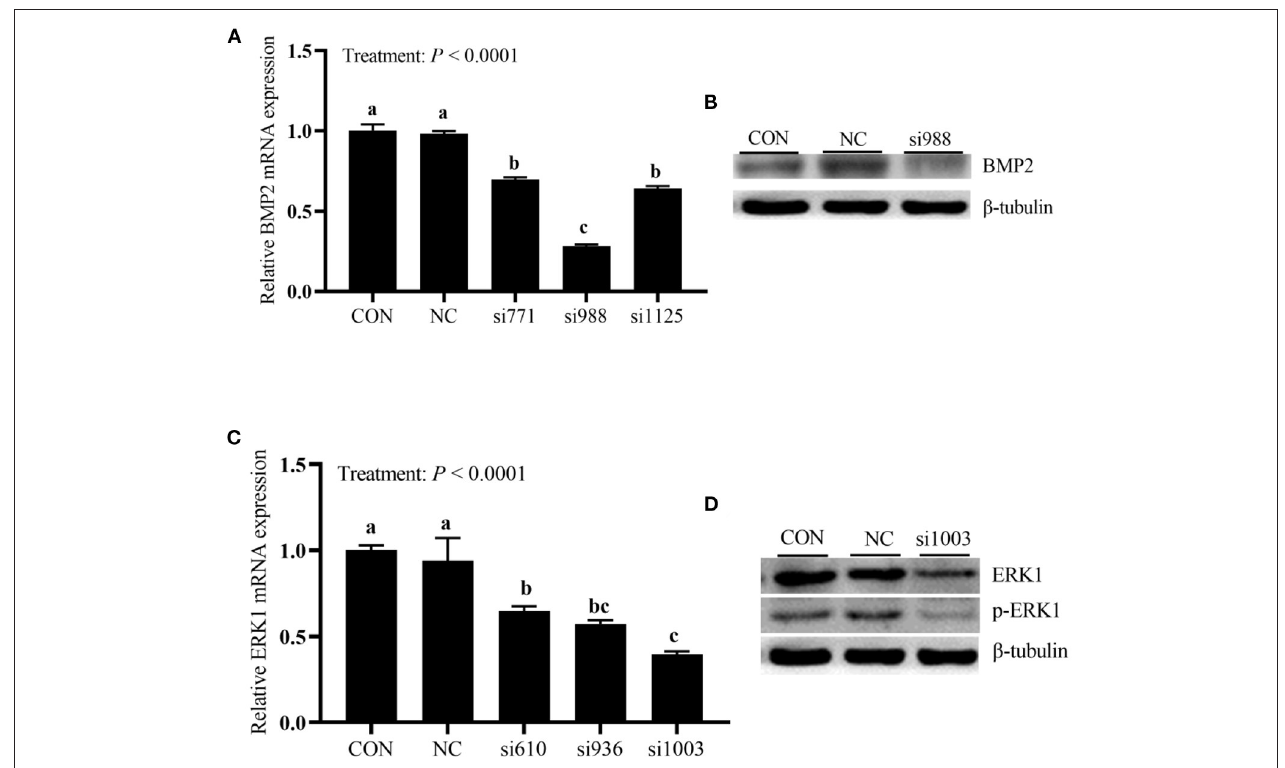
FIGURE 1 | Screening of the most effective siRNAs against BMP2 mRNA and protein (A,B) , and ERK1 mRNA and protein (C,D) in primary broiler osteoblasts (experiment 1). Each value represents the means ± SE, n = 3. Lacking the same letters (a, b, c) means significant differences, P < 0.05. BMP2, bone morphogenetic protein 2; ERK1, extracellular signal-regulated kinase